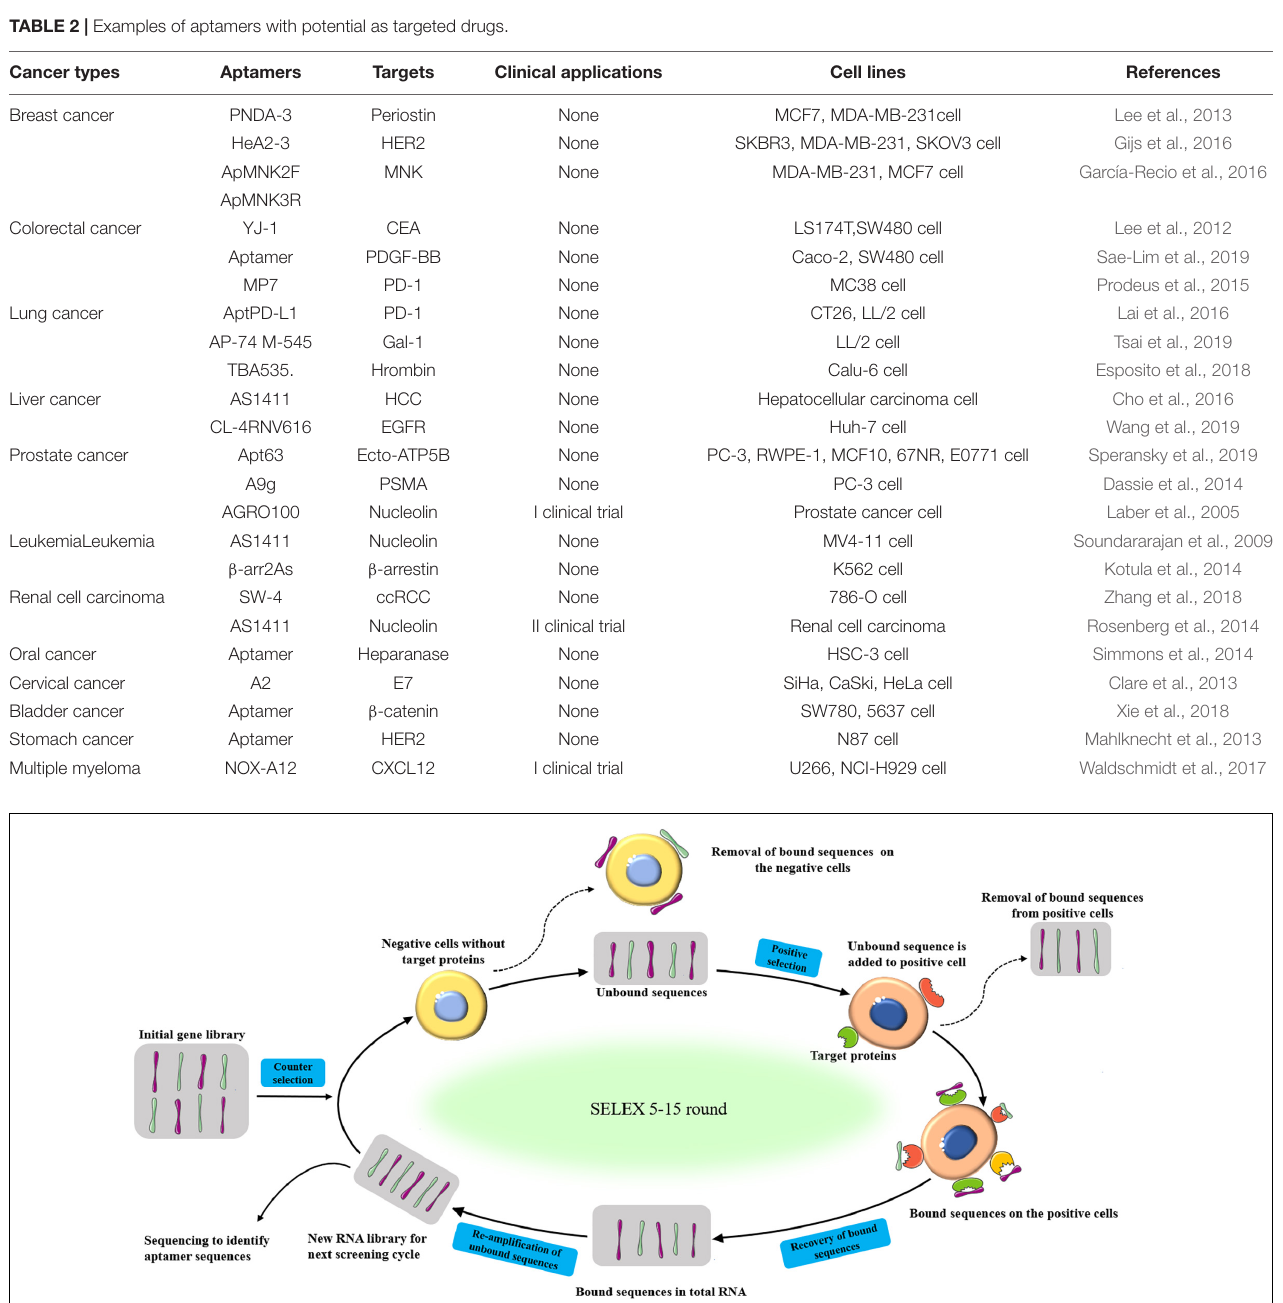
FIGURE 1 | Schematic representation of the SELEX procedure to produced aptamers for specific target biomolecules.